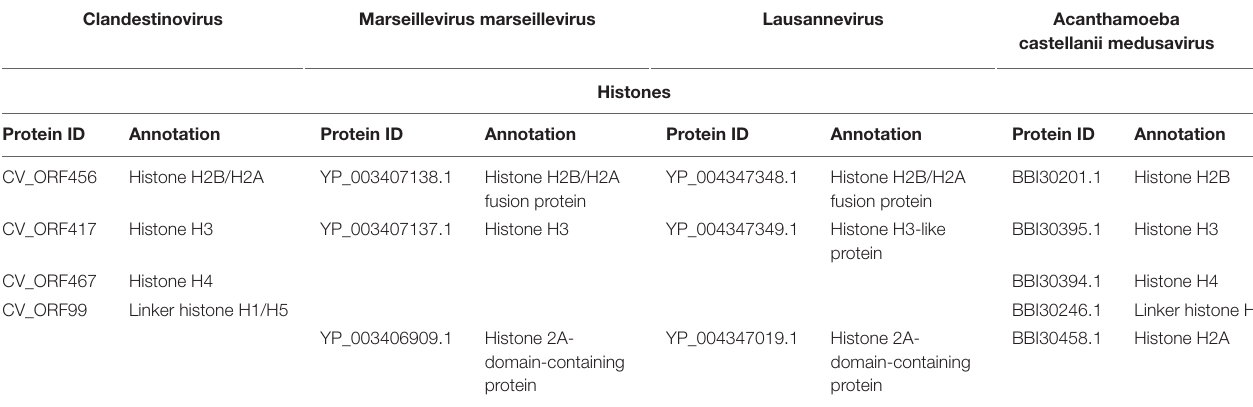
TABLE 3 | Description of proteins associated with histones in Clandestinovirus, Marseillevirus, Lausannevirus, and Acanthamoeba castellanii